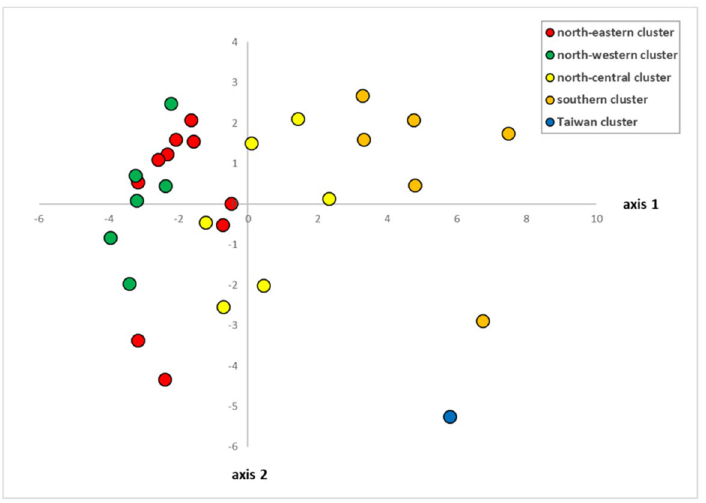
Figure 4. Principal component analysis (PCA) plots with 19 climatic variables (see Supplementary Table S3) of 29 Lindera aggregata populations. Different colours correspond to the five genetic clusters inferred by STRU CTU RE